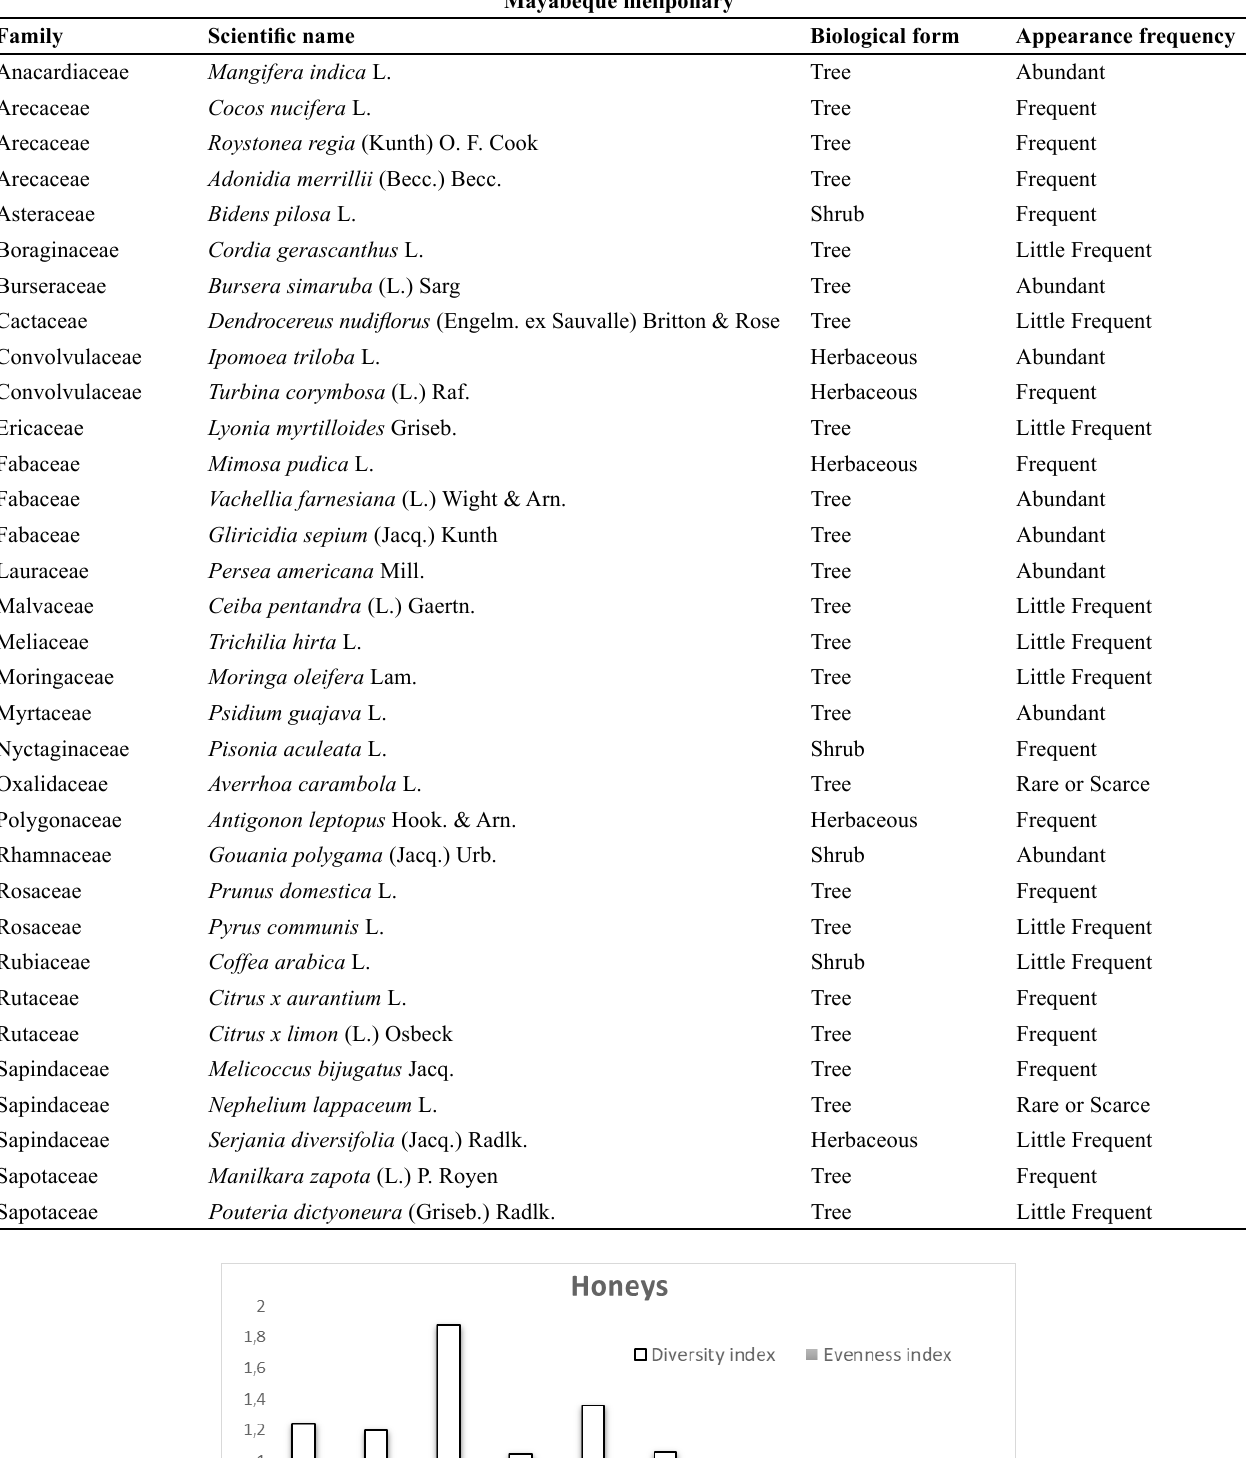
Table 2. Floristic inventory of the Mayabeque locality, Cuba, 2018.